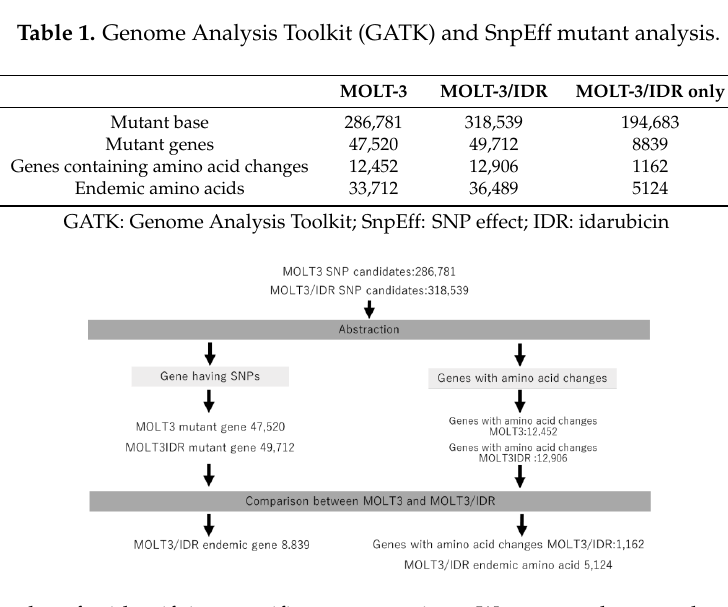
Figure 1. Procedure for identifying specific gene mutations. We extracted mutated genes and genes with amino acid changes from both MOLT-3 and MOLT-3/IDR cells. In addition, we extracted specific genes that only existed in MOLT-3/IDR cells and specific genes with amino acid changes, and then determined the number of mutations in specific amino acids by comparing them. SNP : Single Nucleotide Polymorphism.